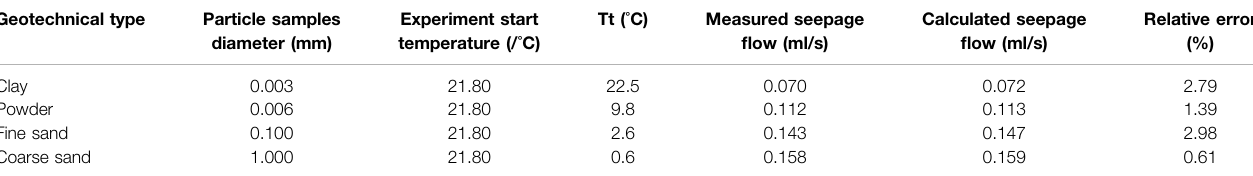
TABLE 3 | Temperature characteristics and seepage fl ow under different geotechnical conditions. Geotechnical